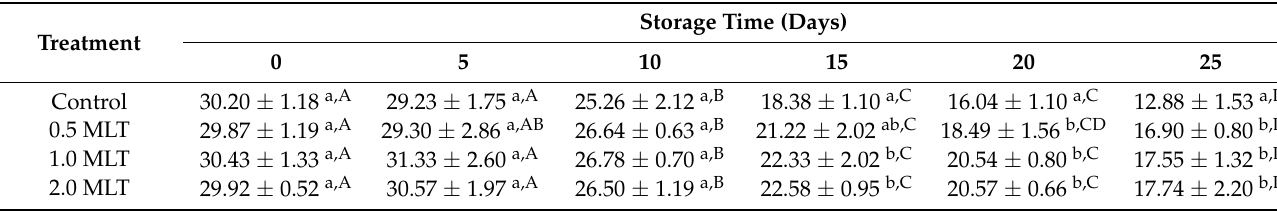
Table 4. Effect of melatonin treatment on vitamin C content (mg/100 g fresh weight) of green asparagus during 25 days of storage at 4 ◦ C and 90% relative humidity.